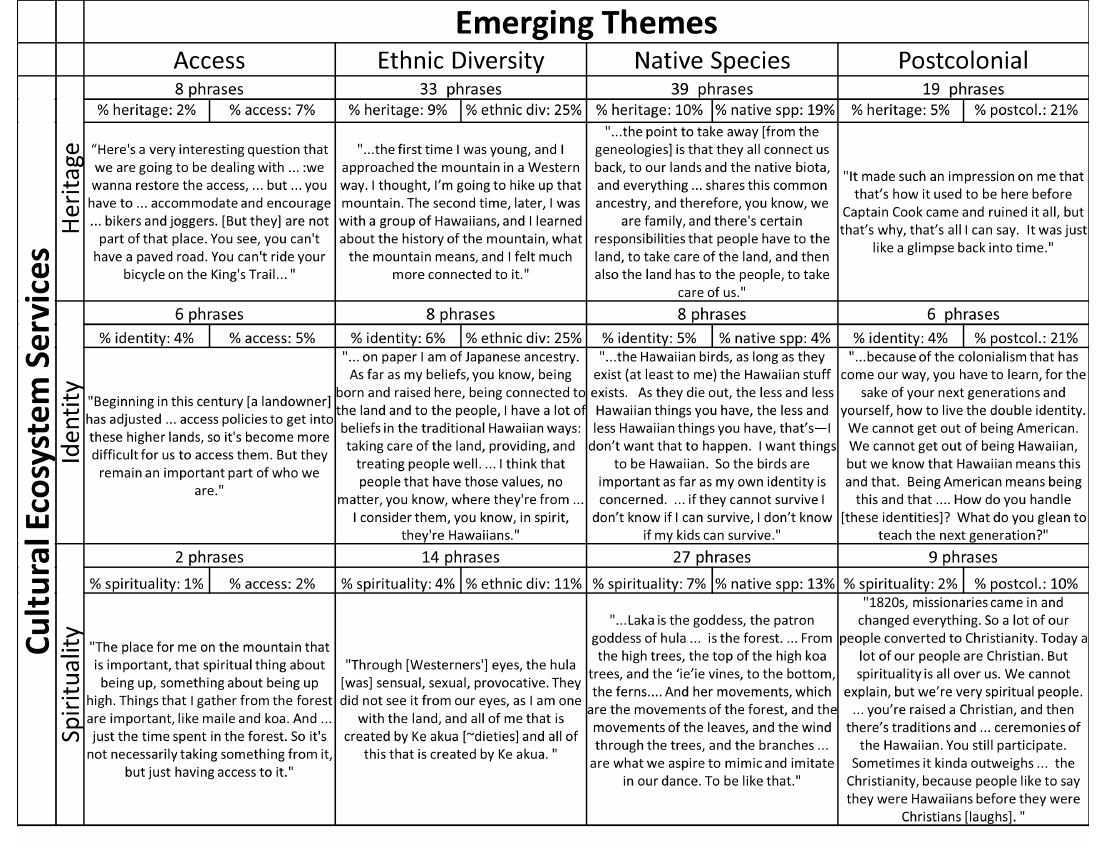
Fig. 6 . Interactions between three most common CES addressed and emerging themes. We provide counts of comments coded as each pair of themes, as well as sample quotations.